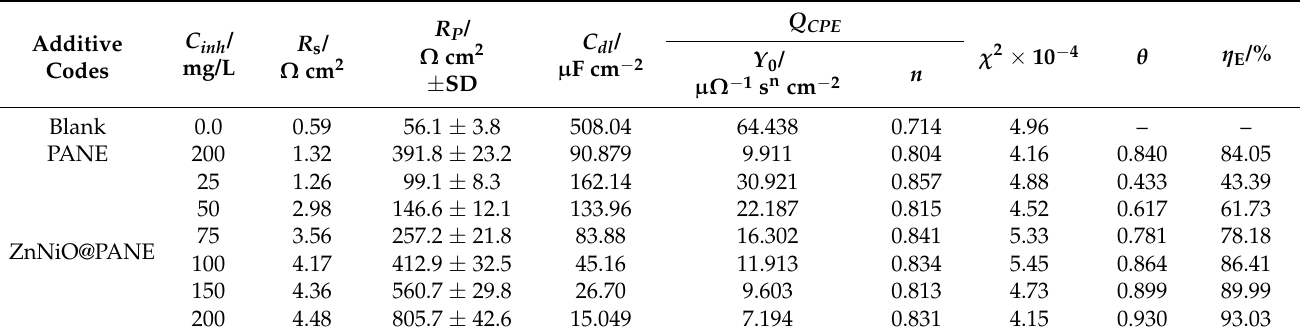
Table 2. EIS parameters of M-alloy corrosion in the blank HCl-containing brine and with the addition of diverse concentrations of ZnNiO@PANE at 298